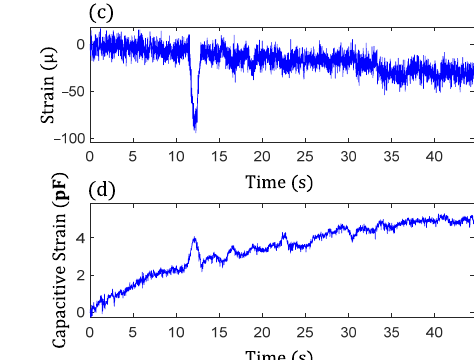
Figure 13. A sample data set from the WLASS including: ( a ) lateral acceleration and ( b ) vertical acceleration; ( c ) cross-frame strain, 𝐹(𝑡) ; and ( d ) large-area strain, ∆𝐶(𝑡) .